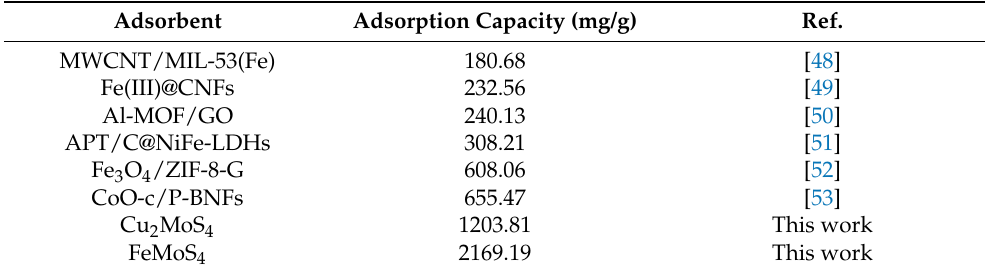
Table 3. Comparison of different adsorbents for optimal CTC adsorption capacity.